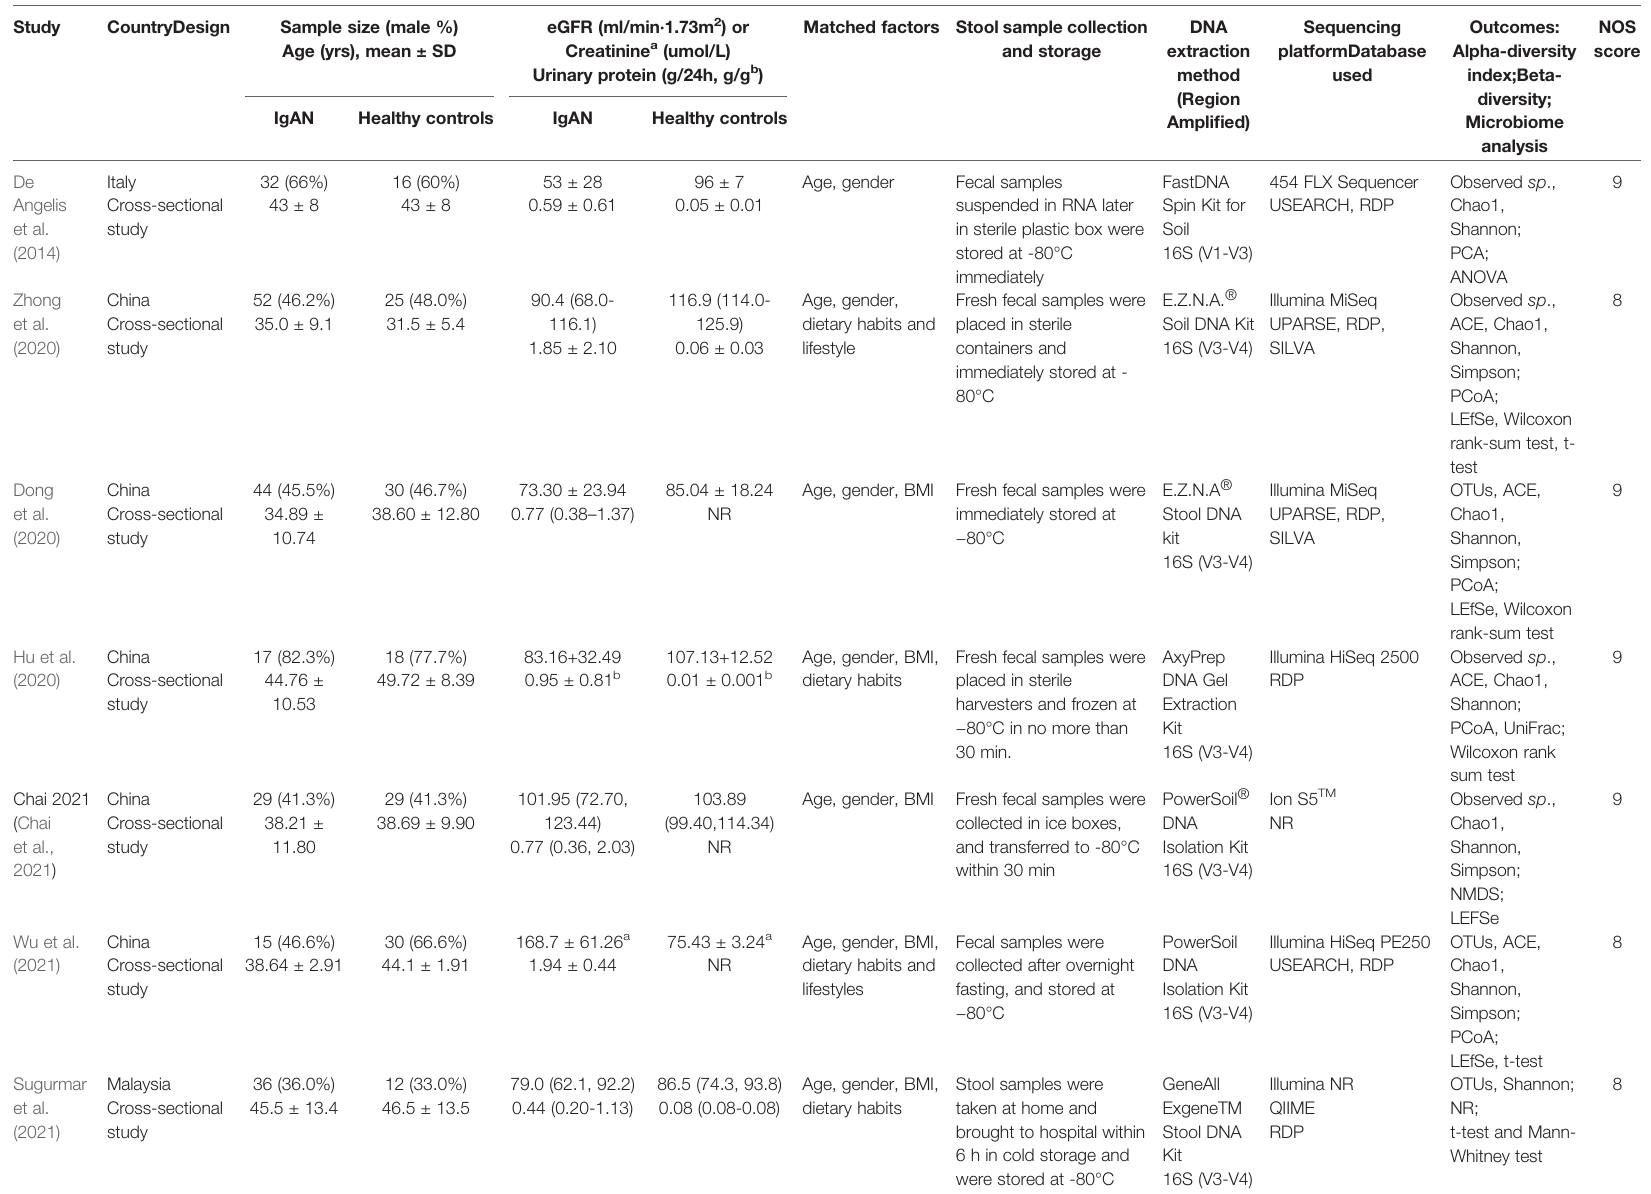
TABLE 1 | Studies characteristics and quality assessments of included